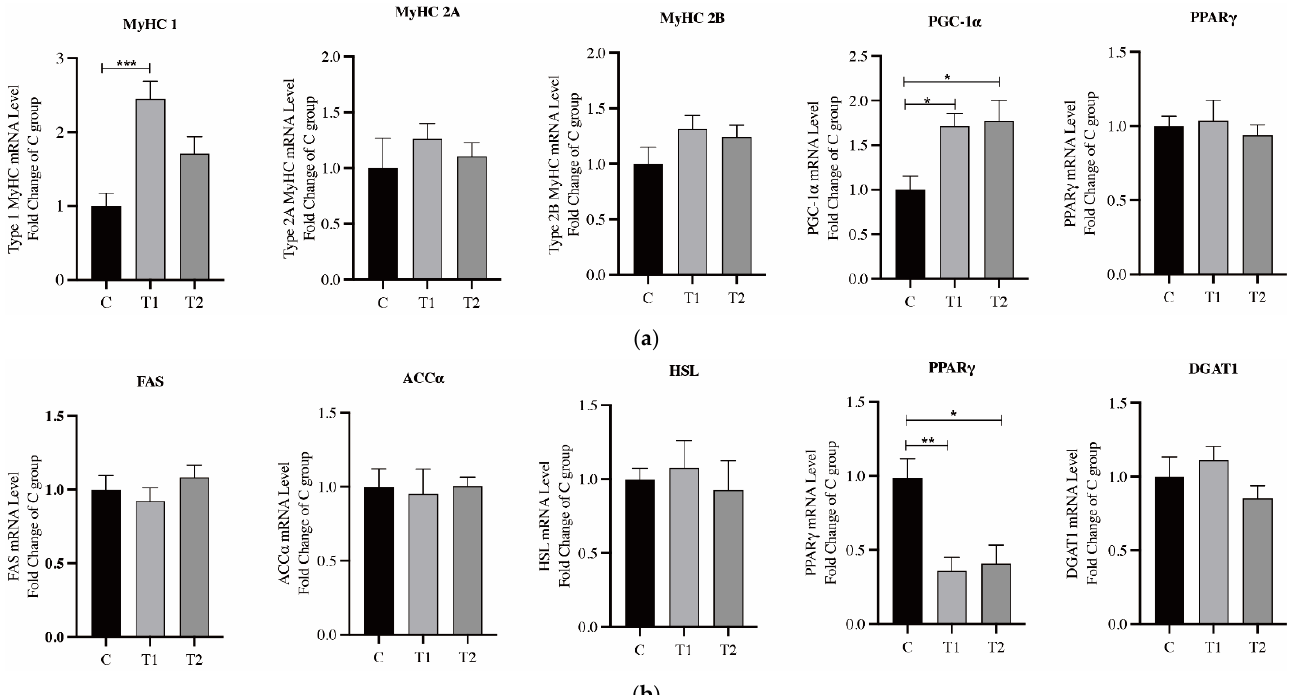
Figure 4. T-PCR was used to detect the expression of myosin heavy chain (MyHC) I, IIa, IIb, peroxisome proliferator-activated receptor- γ coactivator-1 α (PGC-1 α ), peroxisome proliferator-activated receptor γ (PPAR- γ ) in muscle ( a ) and fatty acid synthase (FAS), acetyl coenzyme A carboxylase α (ACC α ), hormone-sensitive lipase (HSL), PPAR- γ , diacylglycerol acyltransferase 1 (DGAT1) in adipose tissue ( b ). Diets with black soldier fly treatments ( p < 0.05) had different bars with various letters. Statistical data were given as mean ± standard error, n = 8. One-way ANOVA and Tukey’s post hoc test were used. * means p < 0.05, ** means p < 0.01, *** means p < 0.001.